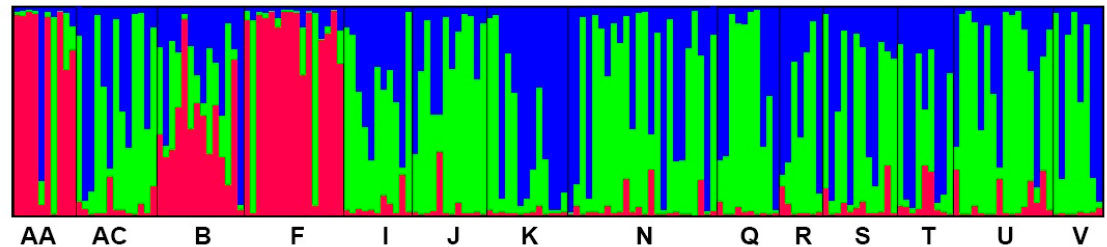
Figure 3. The proportions of cluster memberships at the individual level in the 14 A. cremastogyne populations based on STRUCTURE at K = 3. Each individual is represented by a single vertical bar, which is partitioned into three different colors. Each color represents a genetic cluster (see text for details), and the colored segments shows the individual’s estimated ancestry proportion to each of the genetic clusters. The population codes are as in Table 1.